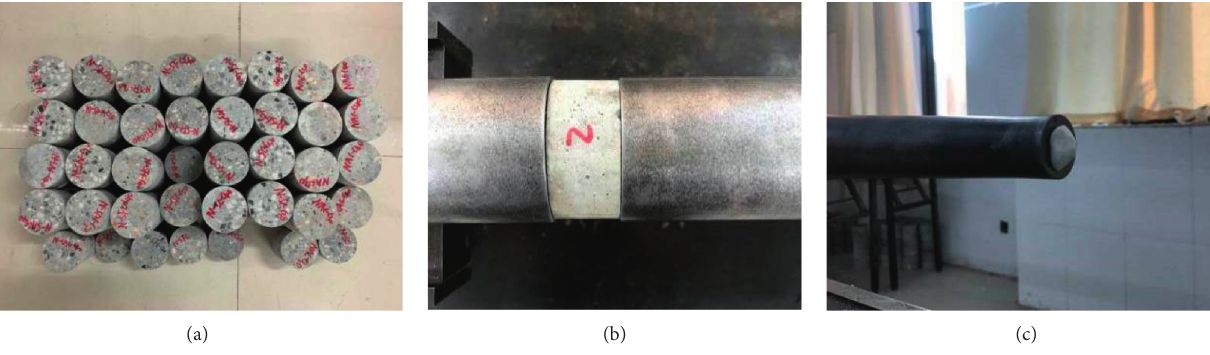
Figure 6: SHPB test specimen. (a) Specimen. (b) Specimen installation. (c) Superlight clay as